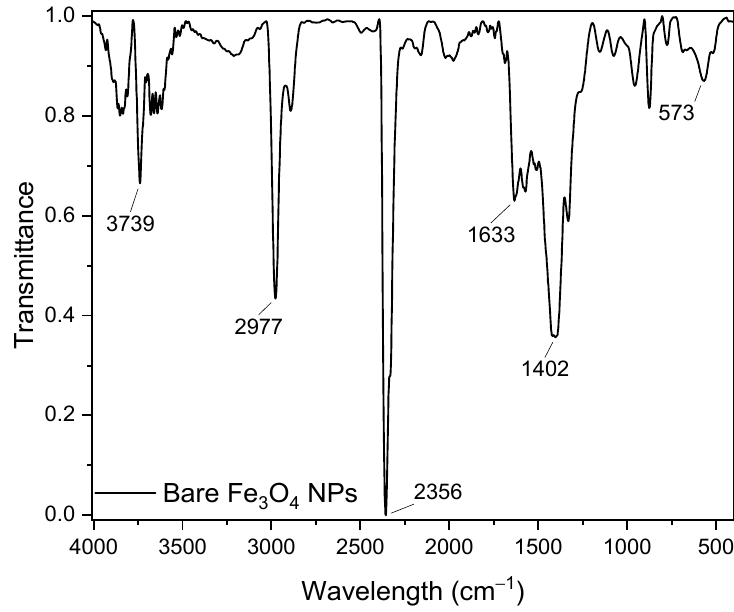
Figure 7. FTIR patterns of bare Fe 3 O 4 NPs.